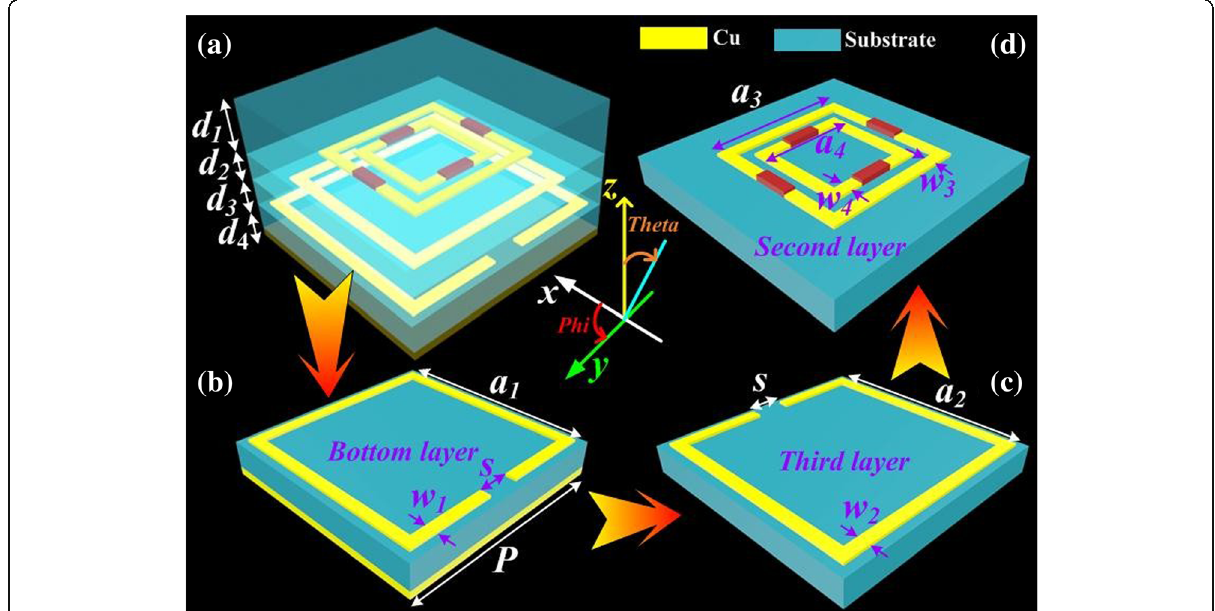
Fig. 1 Schematic geometry of unit cell for the ultra-broadband perfect metamaterial absorber. ( a ) The 3D schematic of a unit cell. ( b ) The bottom layer of proposed PMA with the split ring resonator-II (SRR-II). ( c ) The third layer of proposed PMA with the split ring resonator-I (SRR-I). ( d ) The second layer of proposed PMA with first metallic DSRR (F-MDSRR) microstructure and four lumped resistances. The optimized parameters of the PMA were d 1 = 2 mm, d 2 = d 3 = d 4 = 1 mm, w 1 = w 2 = w 3 = w 4 = 0.8 mm, P = 8.4 mm, R 1,2 = 60 Ω , R 3,4 = 180 Ω , a 1 = 7.8 mm, a 2 = 6.6 mm, a 3 = 5 mm, a s = 1.2 mm. The thickness of the copper is 0.036 4 = 3.4 mm,